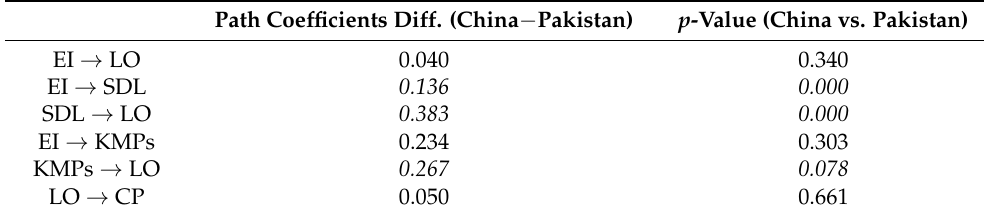
Table 12. Multi-group